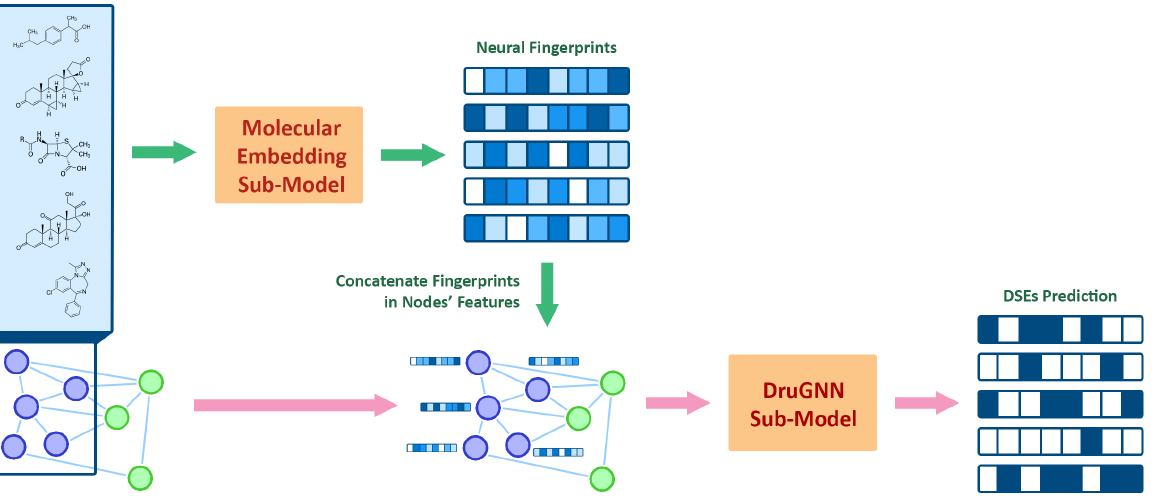
Figure 2. MolecularGNN architecture and processing scheme. Molecular graph structures—representing a single drug node each—are processed by the Molecular Embedding sub-model to produce NFs which are then concatenated to the drug node features vectors. The enriched graph-structured dataset is then processed by the DruGNN module to produce predictions on drug node DSEs. A possible new drug molecule can be added to the dataset by calculating its possible relationships with other nodes in the graph and extrapolating its graph representation from its SMILES code, and the related DSEs can be predicted by just applying the pre-trained model to the new dataset, composed of the one on which the model has been trained, and enriched by the new information derived from the new drug